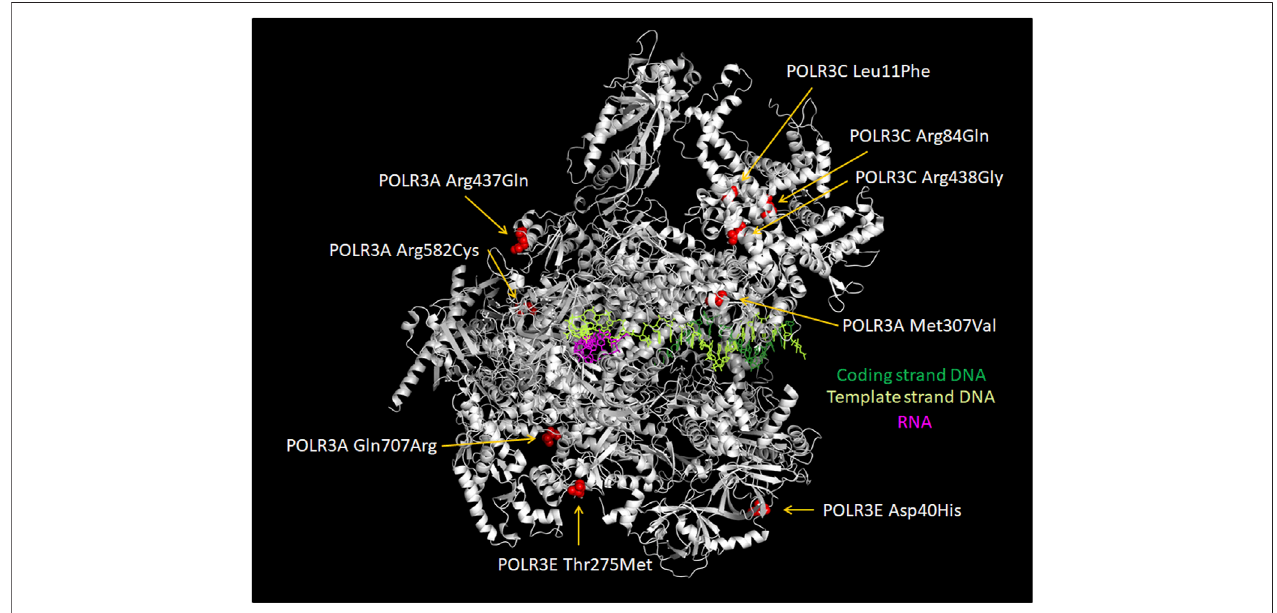
FIGURE11| DistributionofmutationsinRNApolymeraseIIIsubunitsassociatedwithimpairedinnateimmunedefense.Spatialdistributionofaminoacidmutationsthat are associated with severe immune de fi ciency (POLR3E Asp40His) or with varicella zoster virus (VZV)encephalitisand/or pneumonitis (other displayed mutations). Mutated aminoacidsaredepictedasspheresandhighlightedinred.IndividualmutationsinsubunitsPOLR3A,3C,3Eareappropriatelydesignated.ThemutationPOLR3FArg50Trp cannot be displayed since the corresponding sequence was not resolved in the cryo-EM structure (PDB:7ae1). The Figure was created using Pymol.